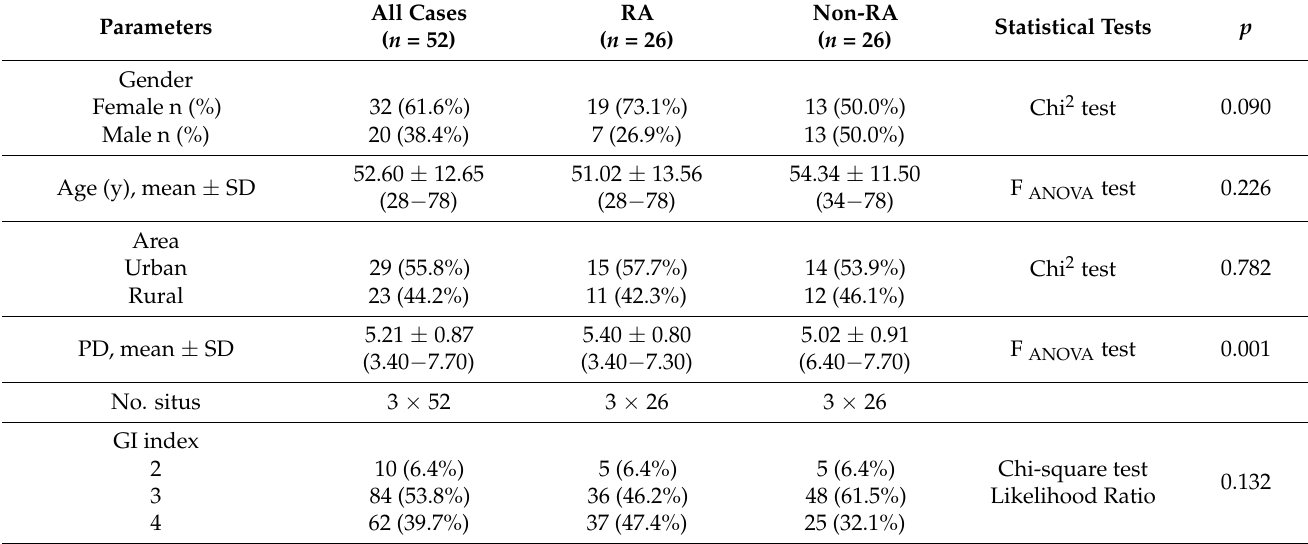
Table 1. Demographic characteristics of the RA group and the non-RA group at baseline for patients.